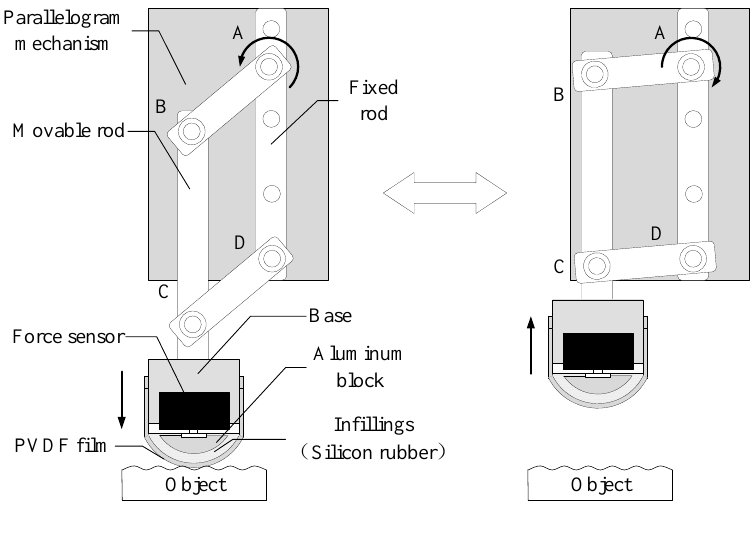
Figure 2. Structure of the finger-shaped tactile